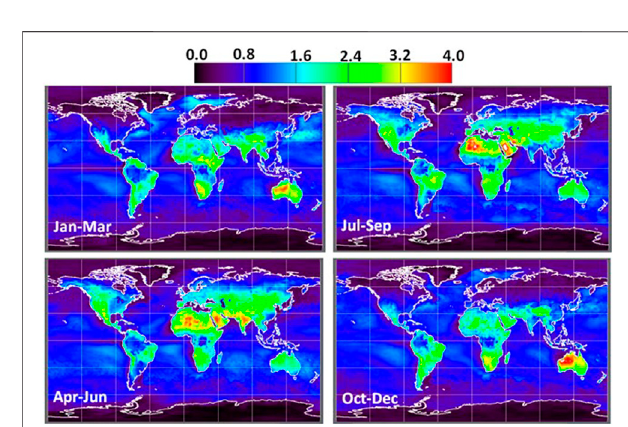
FIGURE 6 | Average PBL height derived from application of the threshold algorithm to ICESat-2 data spanning all of 2019 and displayed in 3 month segments for a grid resolution of 2 × 2 degree.